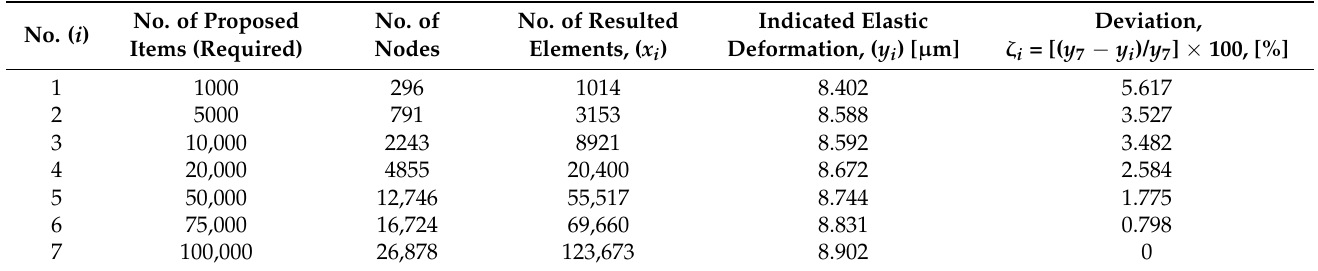
Table 4. Values obtained at FEA study at compression of simple parallelepiped pole body.